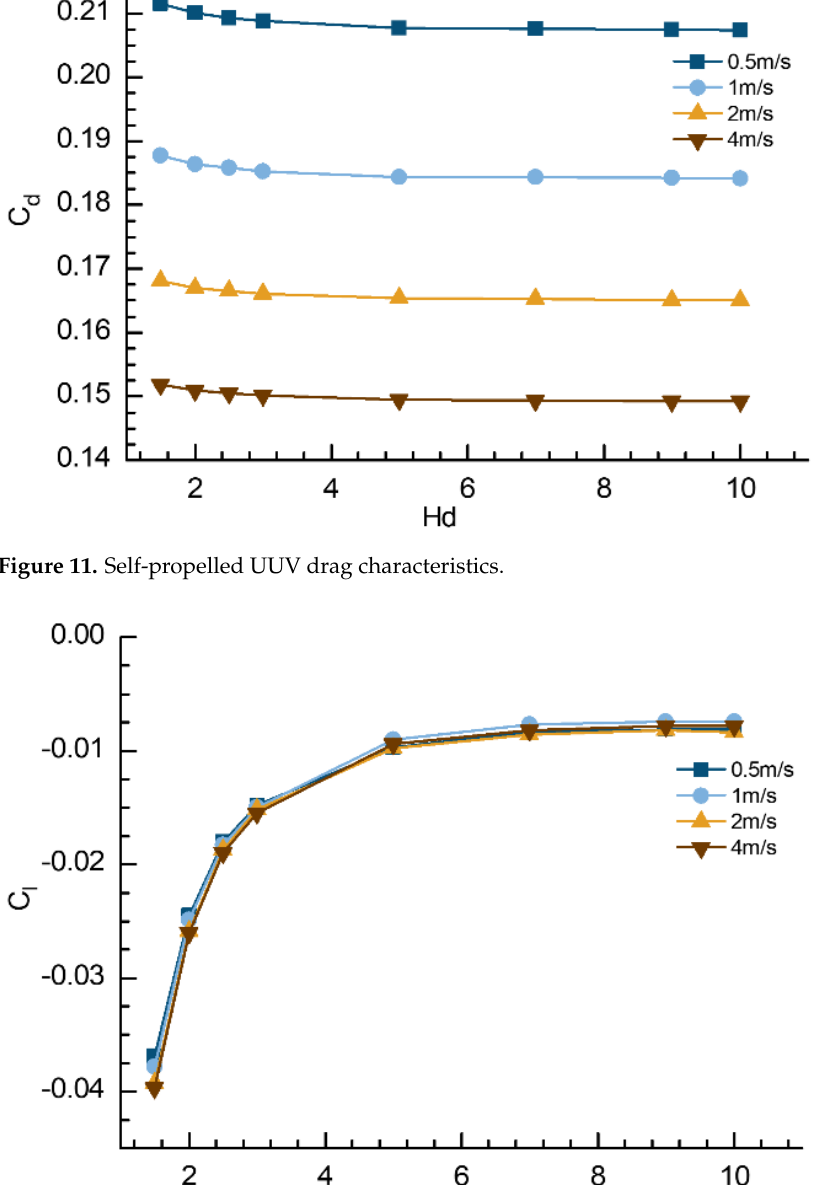
Figure 11. Self-propelled UUV drag characteristics.